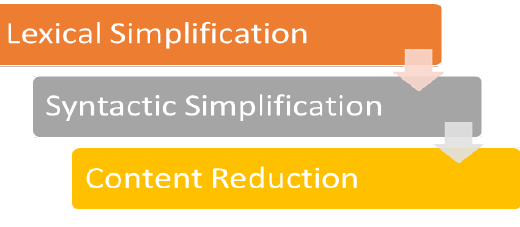
Figure 1. General simplification